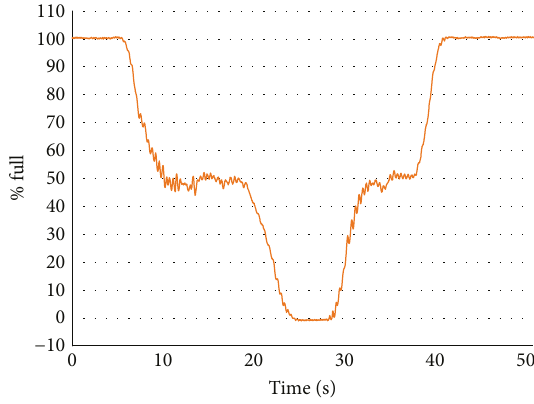
Figure 6: Mass (as % full) in the second half of the tank.